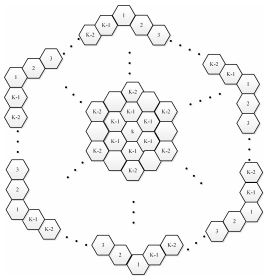
Fig. 3 The circumcoronene series of benzenoid H k